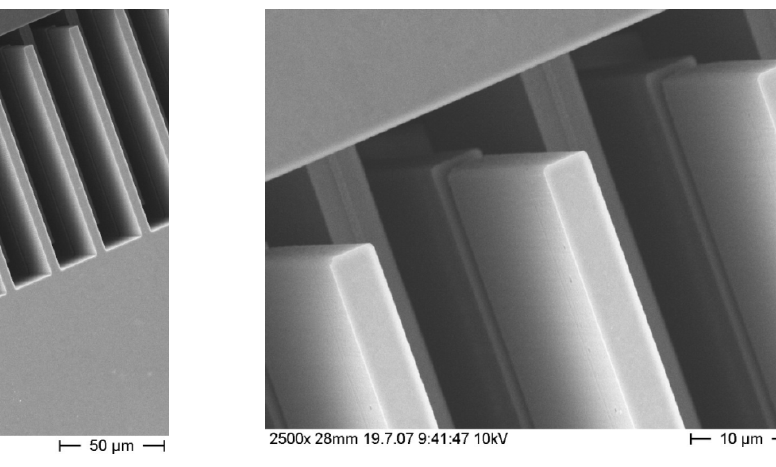
Figure 4. SEM pictures of stacked vertical comb drives fabricated in the dual layer polysilicon SOI